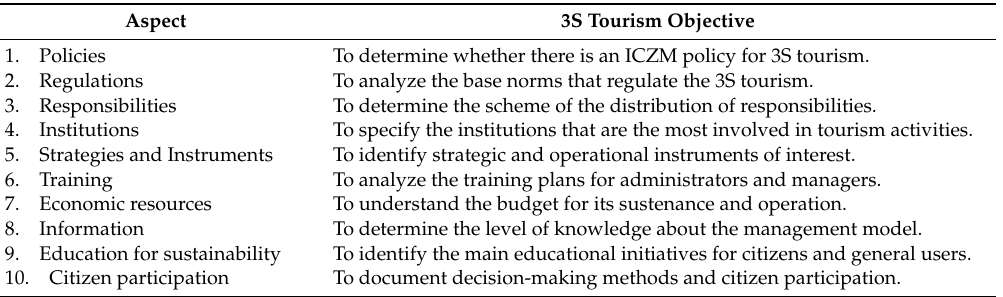
Table 2. Decalogue for the analysis of the current state of ICZM in mainland Ecuador and the Galapagos Islands from the perspective of the 3S